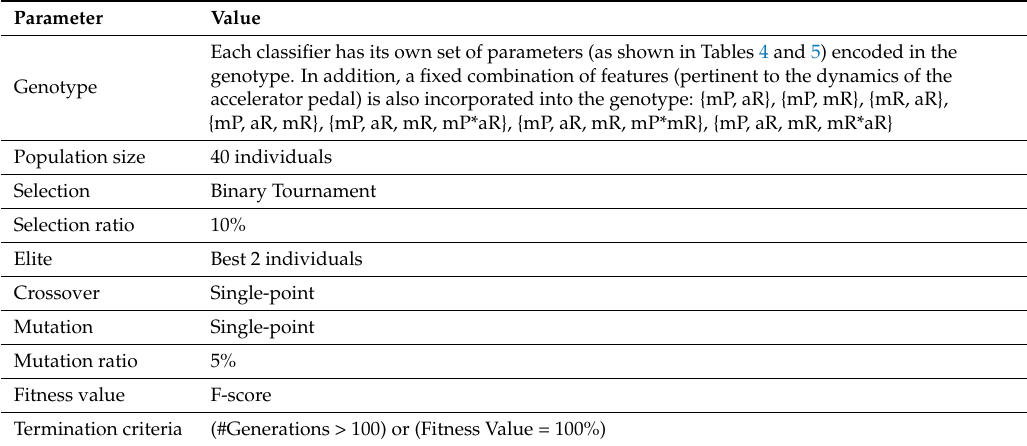
Table 6. Main parameters of